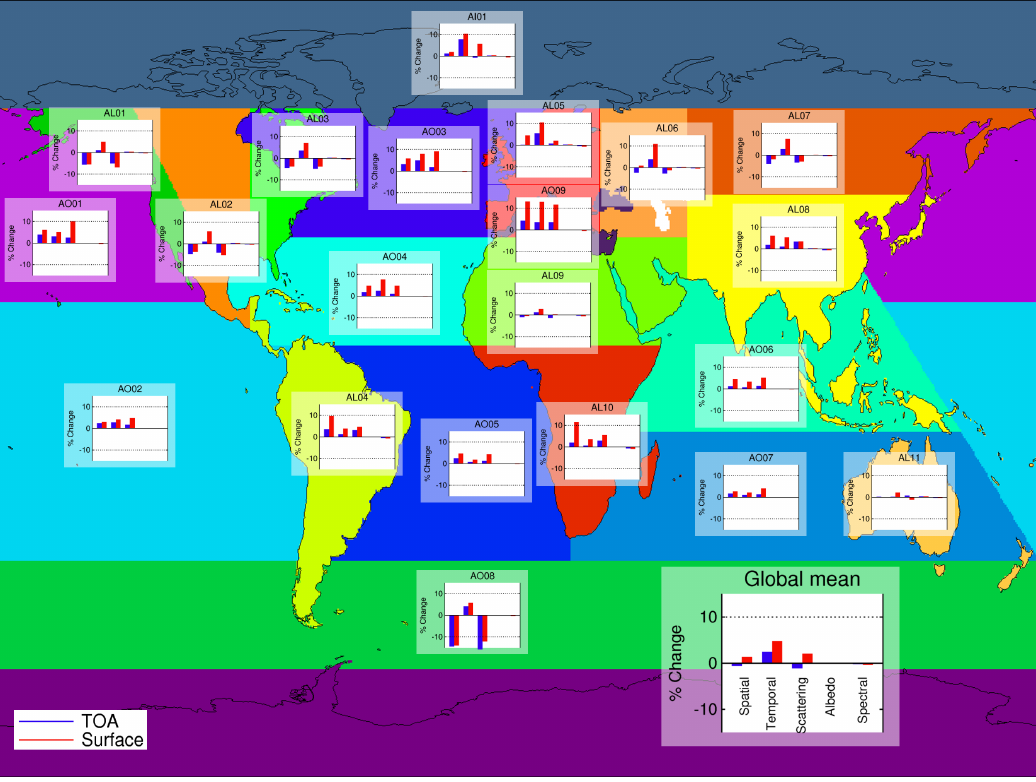
Fig. 4. Percentage differences in TOA and surface ARE for each experiment in each region calculated during April 2007. The plot in the lower left hand corner shows the global mean difference and also illustrates what each bar represents. The tests were not carried out for AI02 due to unavailability of data for this region in